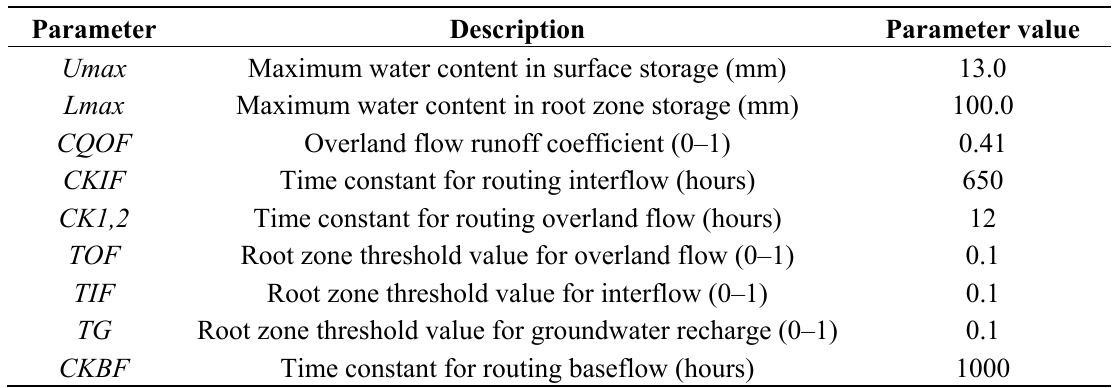
Table 1. Nedbør-Afstrømnings-Model (NAM) parameters of lumped Moose River